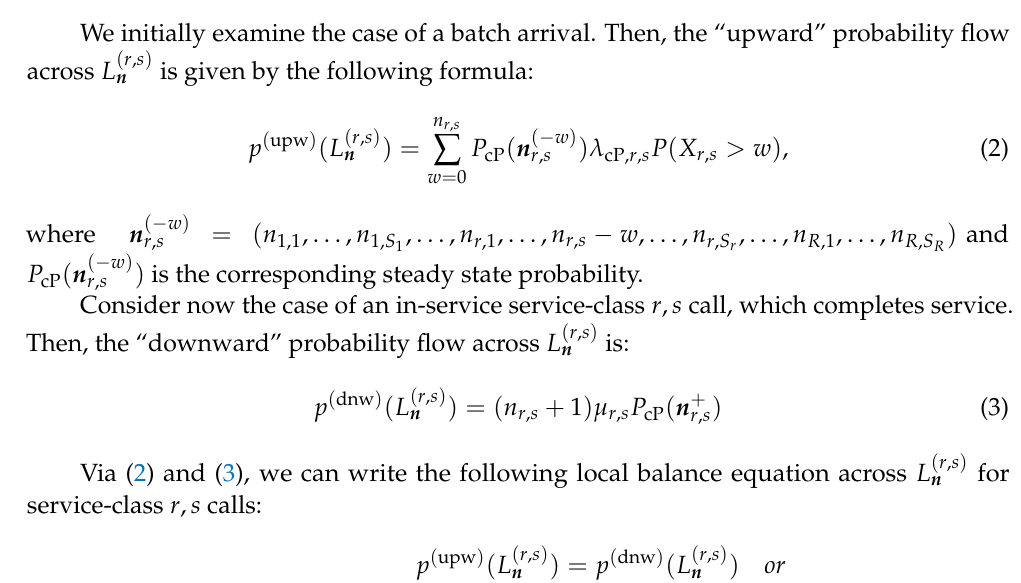
Figure 2. Local balance for the level L